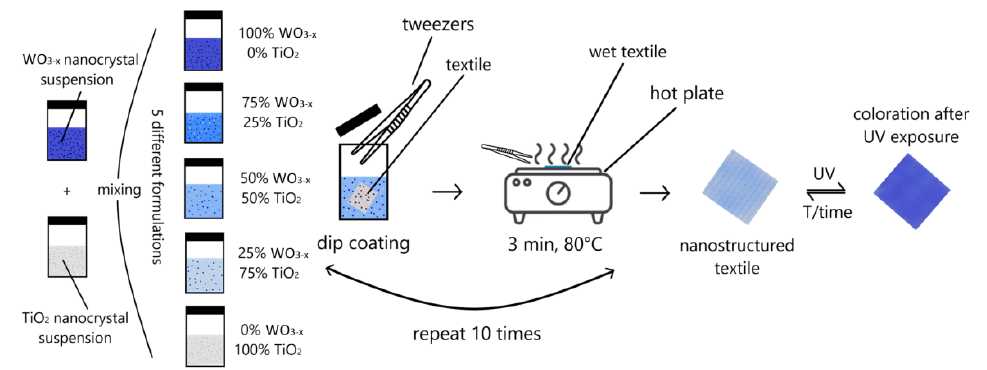
Figure 1. Schematic illustration of textile’s sample functionalization with different TiO 2 and WO 3-x nanoparticle solution compositions .